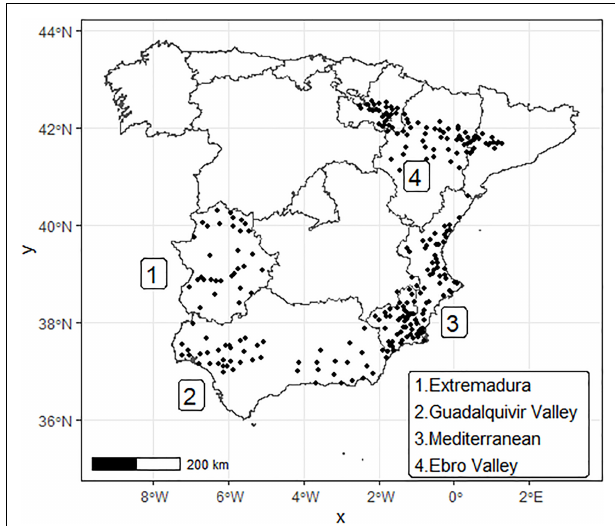
FIGURE 1 | Location of the 270 weather stations (black dots) used for this